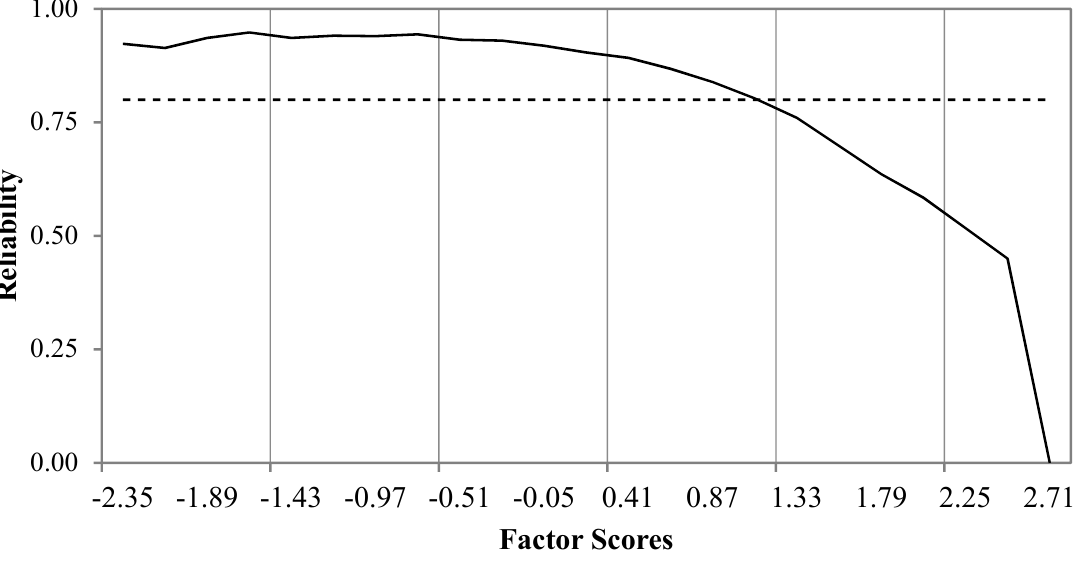
Figure 1. Distribution of conditional Bayes expected a posteriori estimation (EAP) / Orion reliabilities for the factor scores of the unidimensional satisfaction scale obtained from the CSHQ.